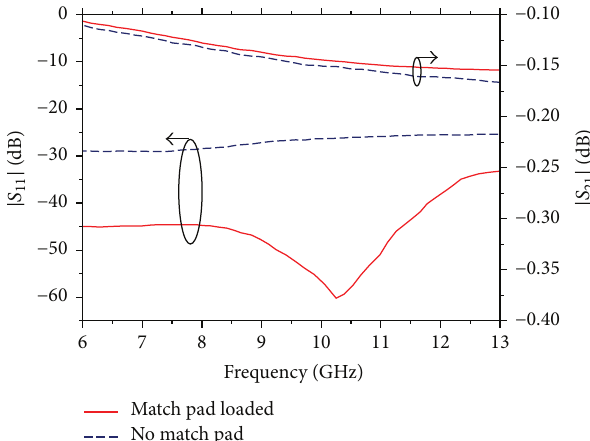
Figure 5: The cut front view of a via transition.